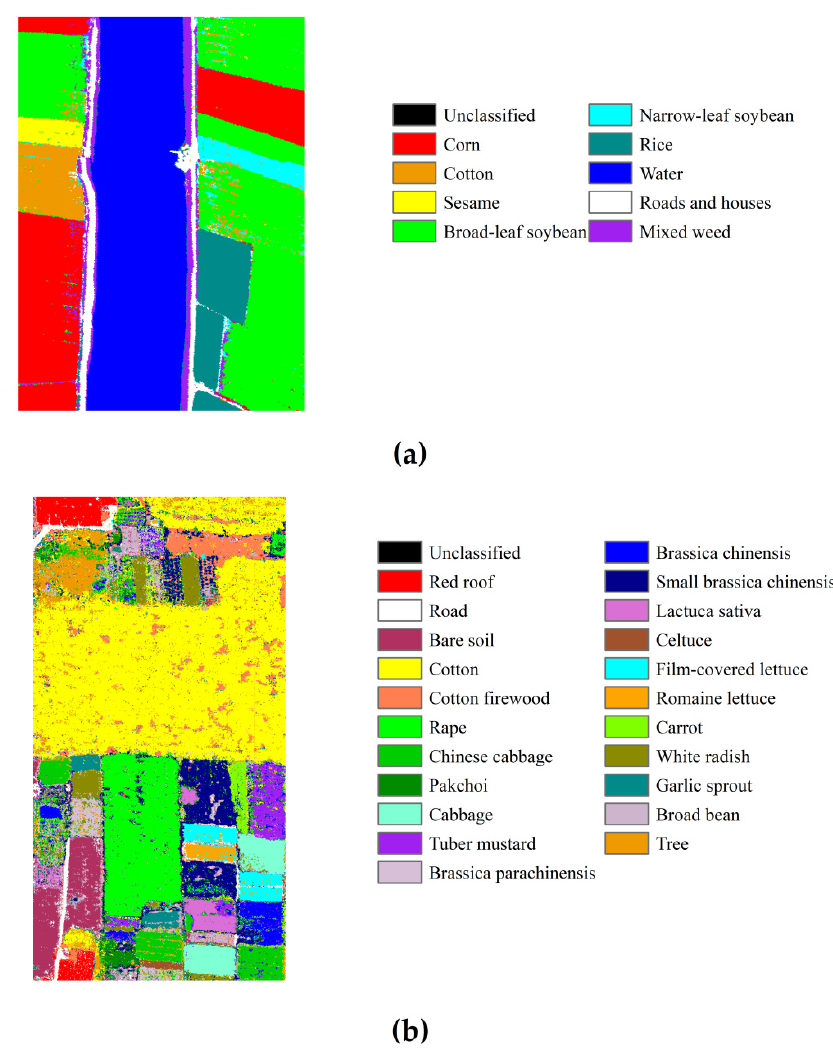
Figure 8. ( a ) Classification results of the random sample set in the Longkou area; ( b ) classification results of the random sample set in the Honghu area.